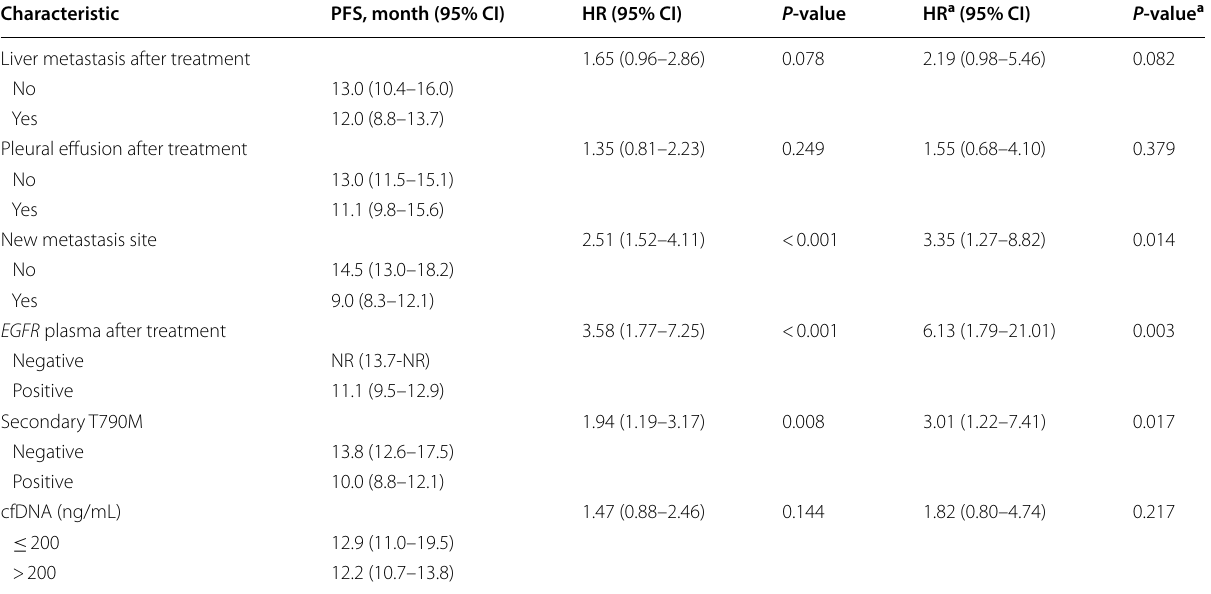
( P < 0.001) and 2.66 ( P 0.031), respectively (Fig. 5a, = b). Notwithstanding, the role of plasma-based second- ary T790M mutation in prognosis for OS was not clear (25.8 months in positive versus 29.5 months in negative patients) (Fig. 5c, d). Patients who have the distant metas- tases to the bone at baseline ( P 0.011, Fig. 5e) and post- = treatment ( P 0.003, Fig. 7a), the new lesion ( P < 0.001, = Fig. 6c) or brain metastasis at post-treatment ( P 0.032, = Fig. 6e) have the shorter OS compared to others. Other- wise, surgery before TKI treatment help to prolong the OS time in NSCLC (not reached versus 28.6 months in TKI chemo-/radiotherapy and 25.2 months in TKI + alone) ( P 0.016). This difference was observed in all = patients as well as in the newly diagnosed group (Fig. 6a, b). The high level of cfDNA concentration was closely associated with the worse survival ( P 0.019) which was = regenerated by the limited data of the newly diagnosed group ( P 0.003) (Fig. 7c, d). Liver metastasis after treat- = ment also was an inferior prognostic factor for OS